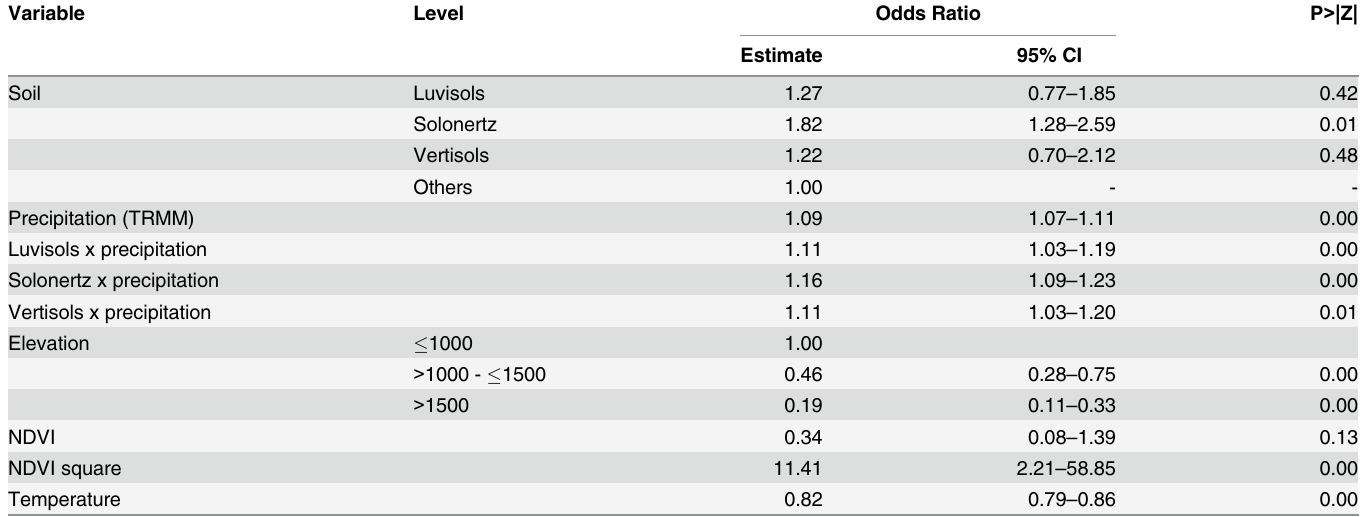
Table 3. Multivariable logistic regression models fitted to the 2006/2007 RVF outbreak data in Kenya.